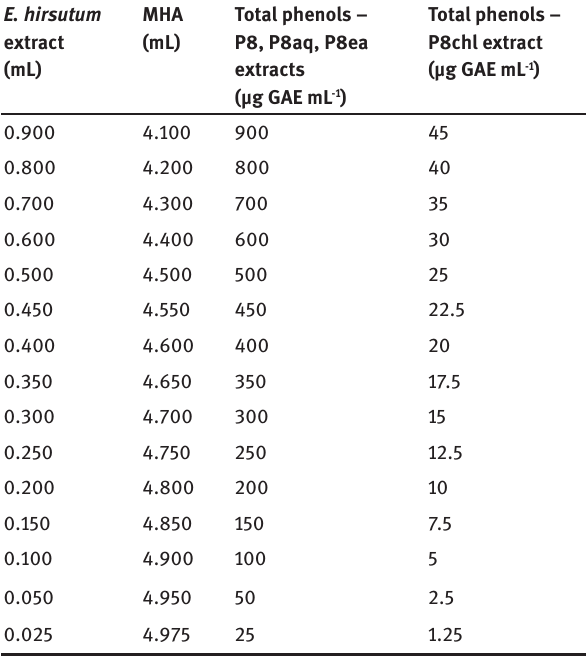
Table 1: Dilution series for MIC assay - working